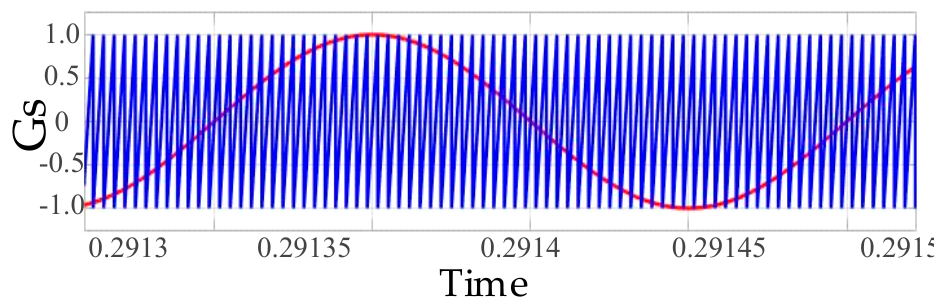
Figure 6. Comparing the sinusoidal waveform with the sawtooth carrier waveform.